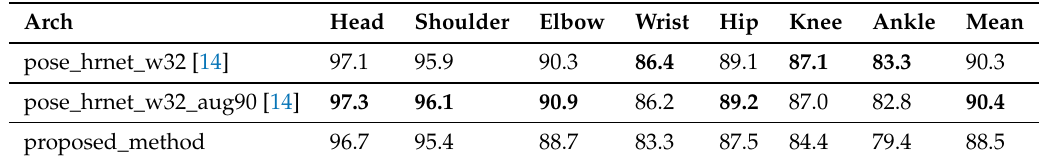
Table 2. Evaluation of the pose estimation task in our multitask-based method versus pose estimation as a single task on the MPII Human Pose Dataset [17]. The performance metric used is PCKh@0.5 [17]. Bold font indicates the best